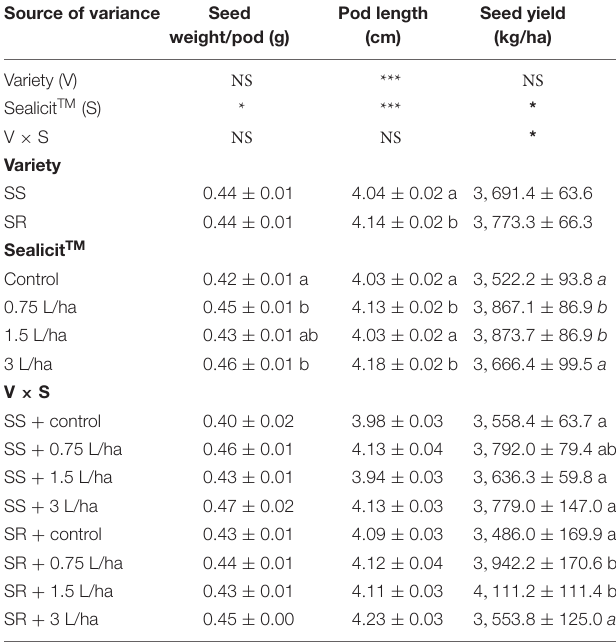
TABLE 1 | Analysis of variance and mean comparisons for fresh seed weight per pod, pod length, and harvested seed yield at full maturity stage (R8) with two commercial soybean varieties treated with water and three concentrations of Sealicit TM